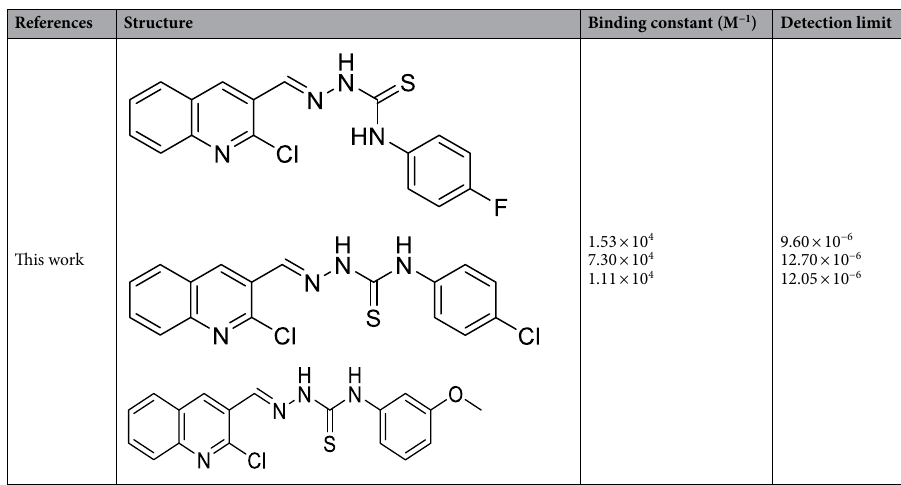
Table 1. Comparison of Limits of detection and binding constants of receptors RB-1 to RB-3 with other reported